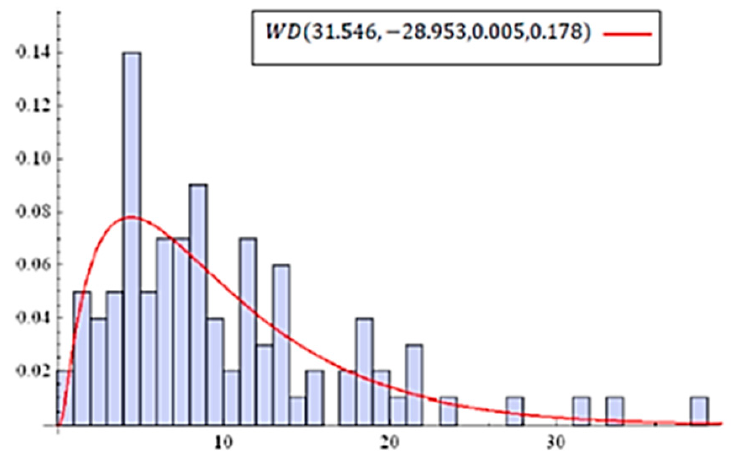
Figure 8. Estimated density of 𝑊𝐷(𝛼, 𝛽, 𝛾, 𝜆) for data set 4.